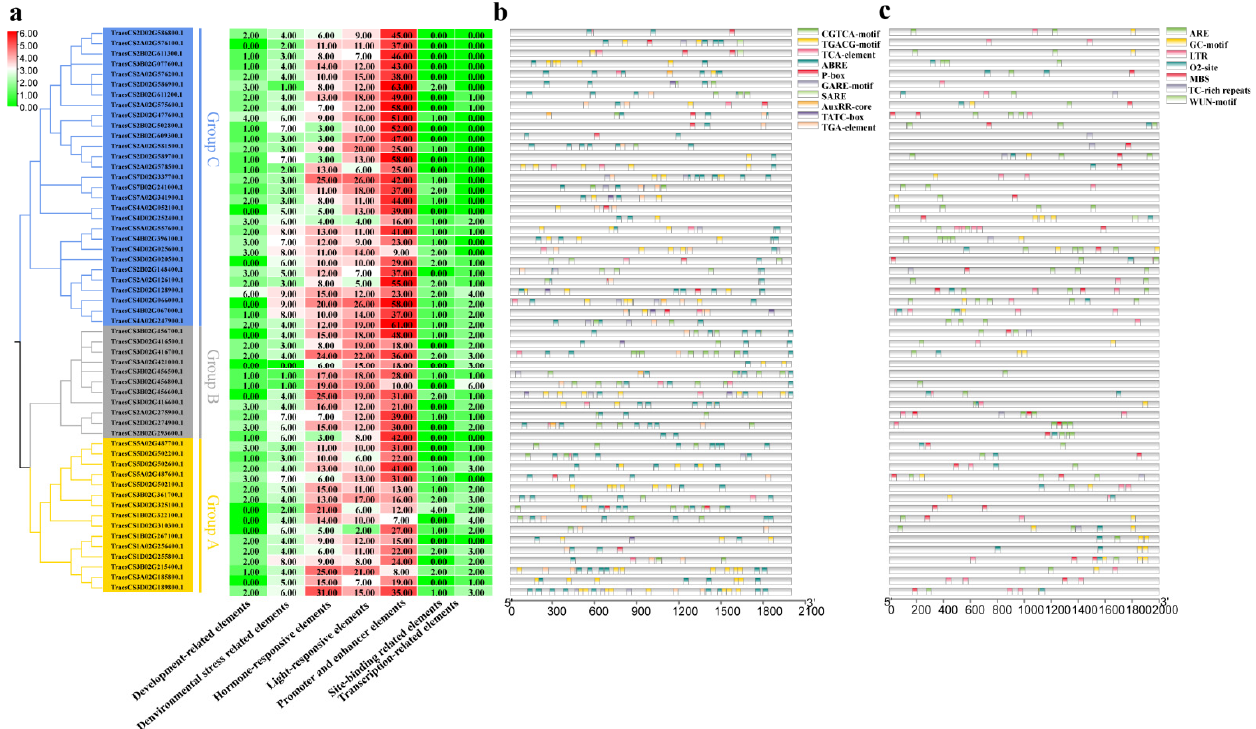
Figure 7. Prediction analysis of cis-acting regulatory elements in TaCystatins . ( a ) The number of seven different kinds of cis-acting elements in the promoter region of TaCystatins . ( b ) The type and position of hormone-responsive elements in TaCystatins . ( c ) The type and position of environmental stress-related elements in TaCystatins .